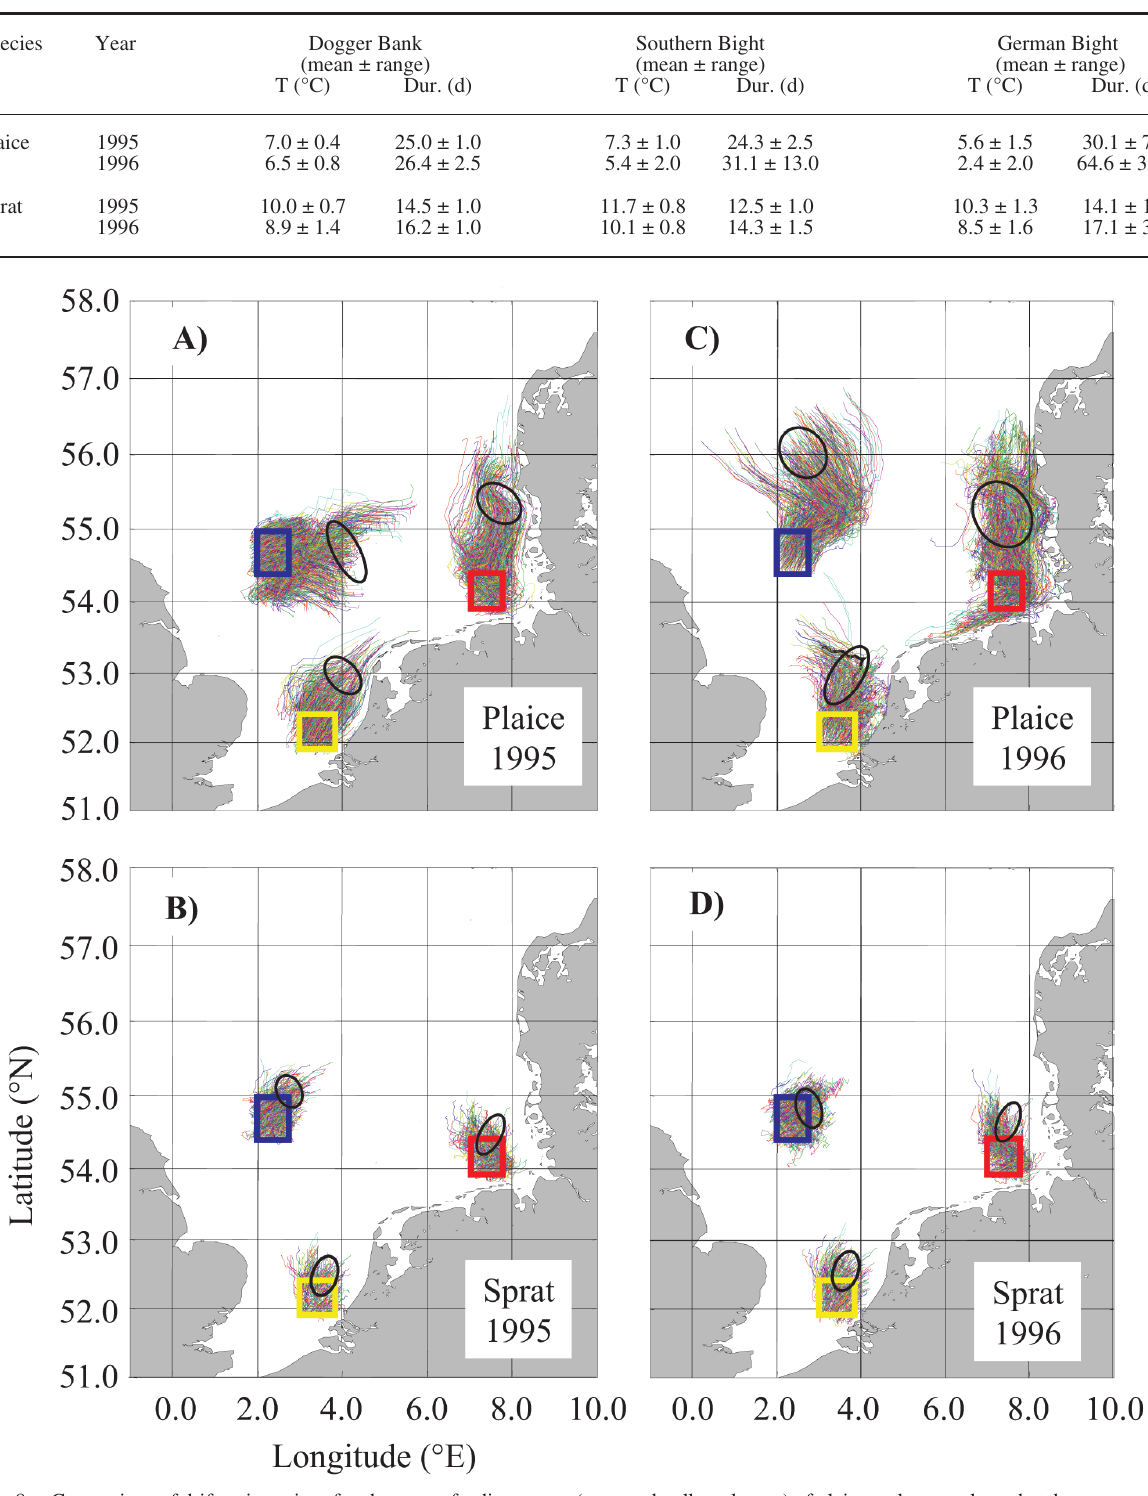
T ABLE 2. – Mean water temperatures and drift durations experienced by plaice and sprat eggs and yolksac larvae released at three different spawning locations in the North Sea. The range in mean temperatures for >2100 particles at each location is also provided. Drift simulations